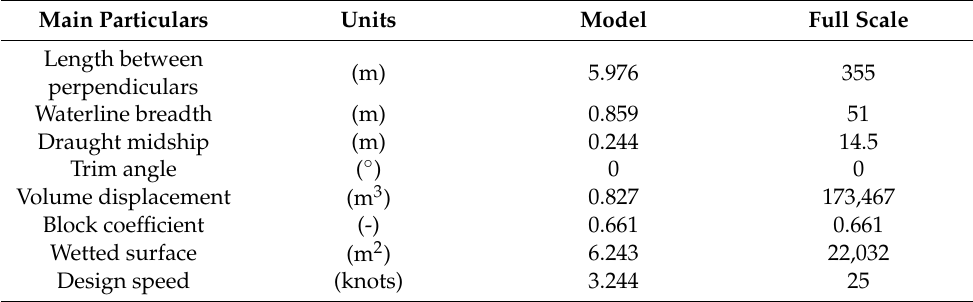
Table 1. Main characteristics of the Duisburg Test Case (DTC).